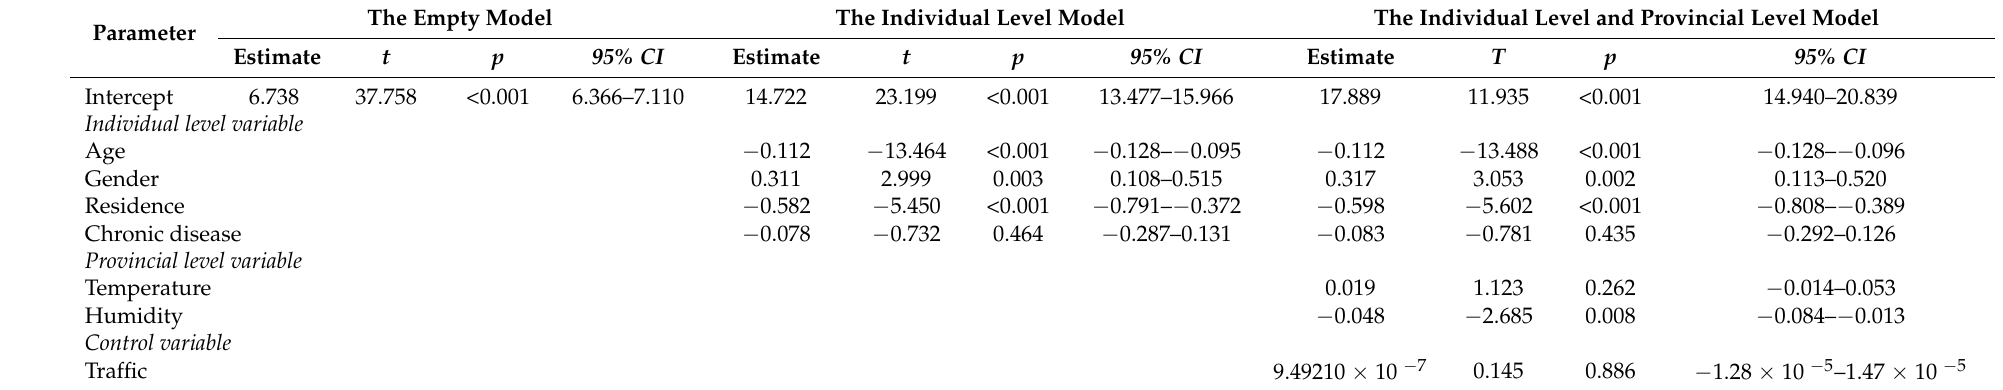
Table 4. The main effects of the empty, individual level, and provincial level